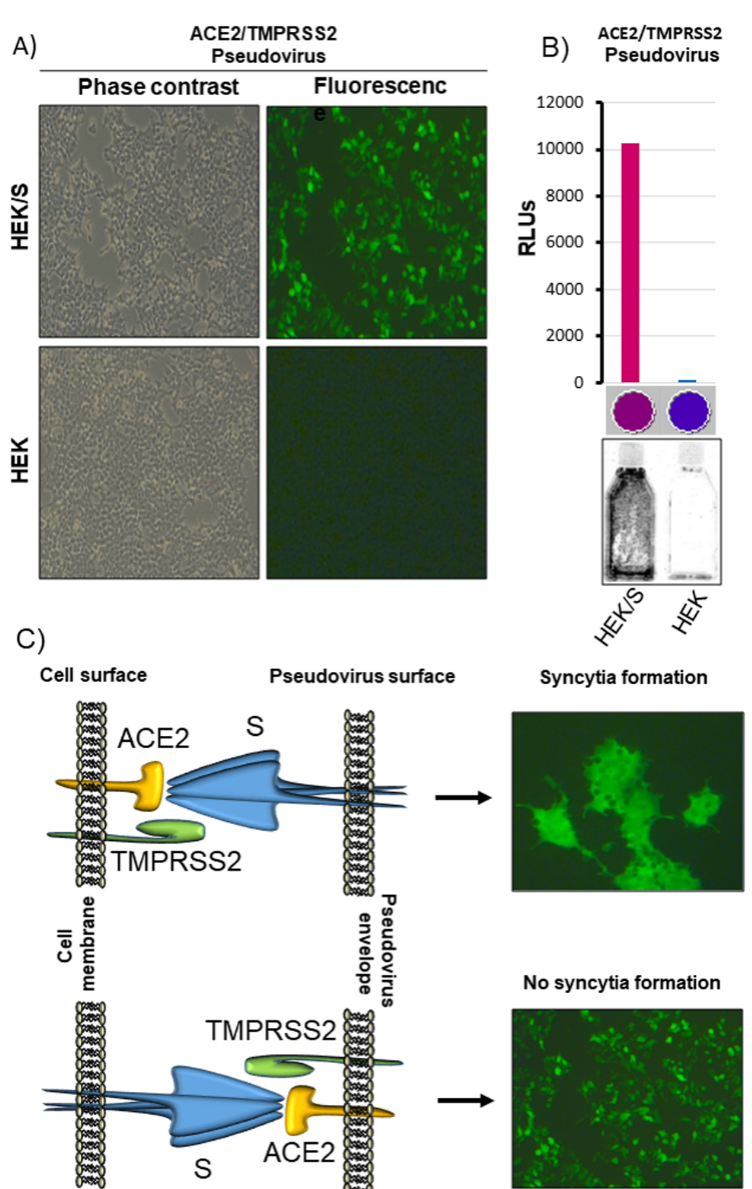
Figure 3. Pseudovirus generation with ACE2 and TMPRSS2. ( A ) Representative image (phase con- trast and fluorescence of the same field; 10X) of HEK/S- Δ RS-HA/Puro cells (HEK/S) and HEK293T cells (HEK) transduced with ACE2/TMPRSS2 pseudovirus. ( B ) Representative 25 cm 2 flasks of HEK/S- Δ RS-HA/Puro cells (HEK/S) and HEK293T cells (HEK) transduced with ACE2/TMPRSS2 pseudovirus and exposed to the ChemiDoc apparatus. Luminometric quantification of the lysate of the same cells, expressed as relative luciferase units (RLUs) and colorimetrically visualized (violet and blue spots) by the luminometer software, during and after reading. ( C ) Drawing explaining the lack of syncytia generation by ACE2/TMPRSS2 pseudovirus.